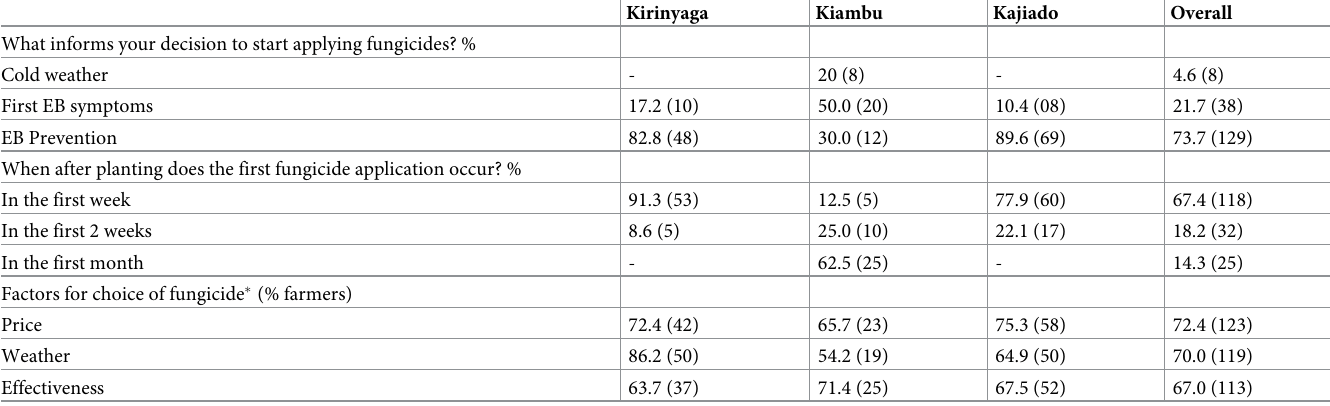
Table 6. Decision factors on fungicide application among tomato farmers in Kirinyaga, Kiambu, and Kajiado counties of Kenya, January-March 2021. Kirinyaga Kiambu Kajiado